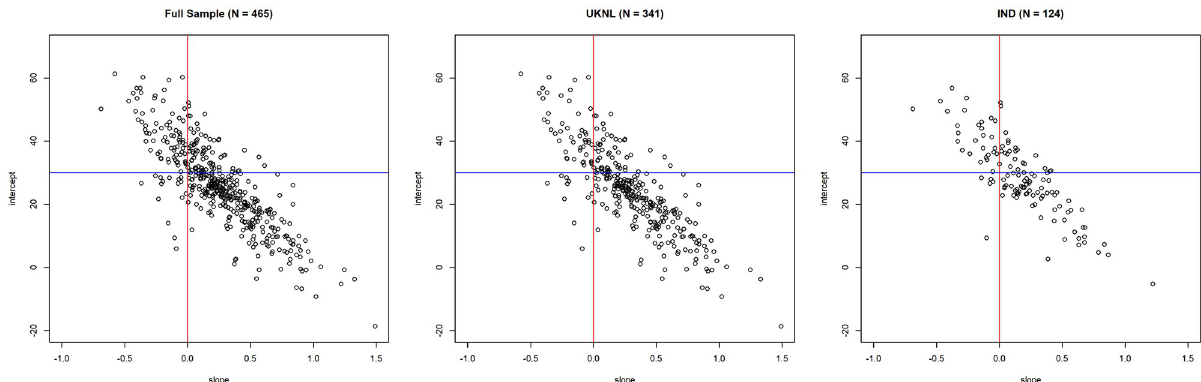
Fig 5. Plot of intercept and slope of LCP scores.